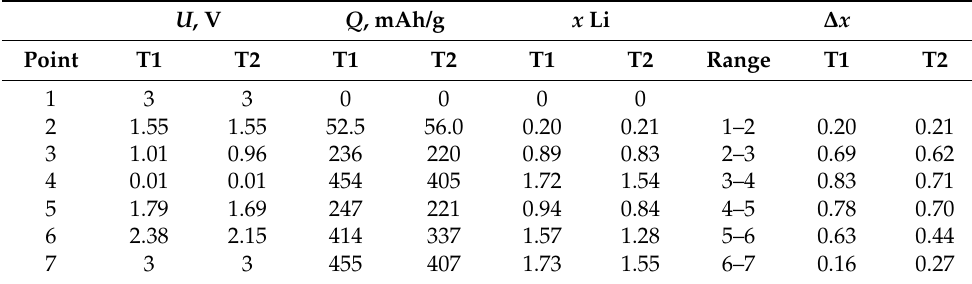
Table 2. Potential and amount of lithium introduced or extracted for the characteristic points on the charge and discharge curves of cycle 2 (Figure 1b) and their corresponding x and increment ∆ x at each interval between these